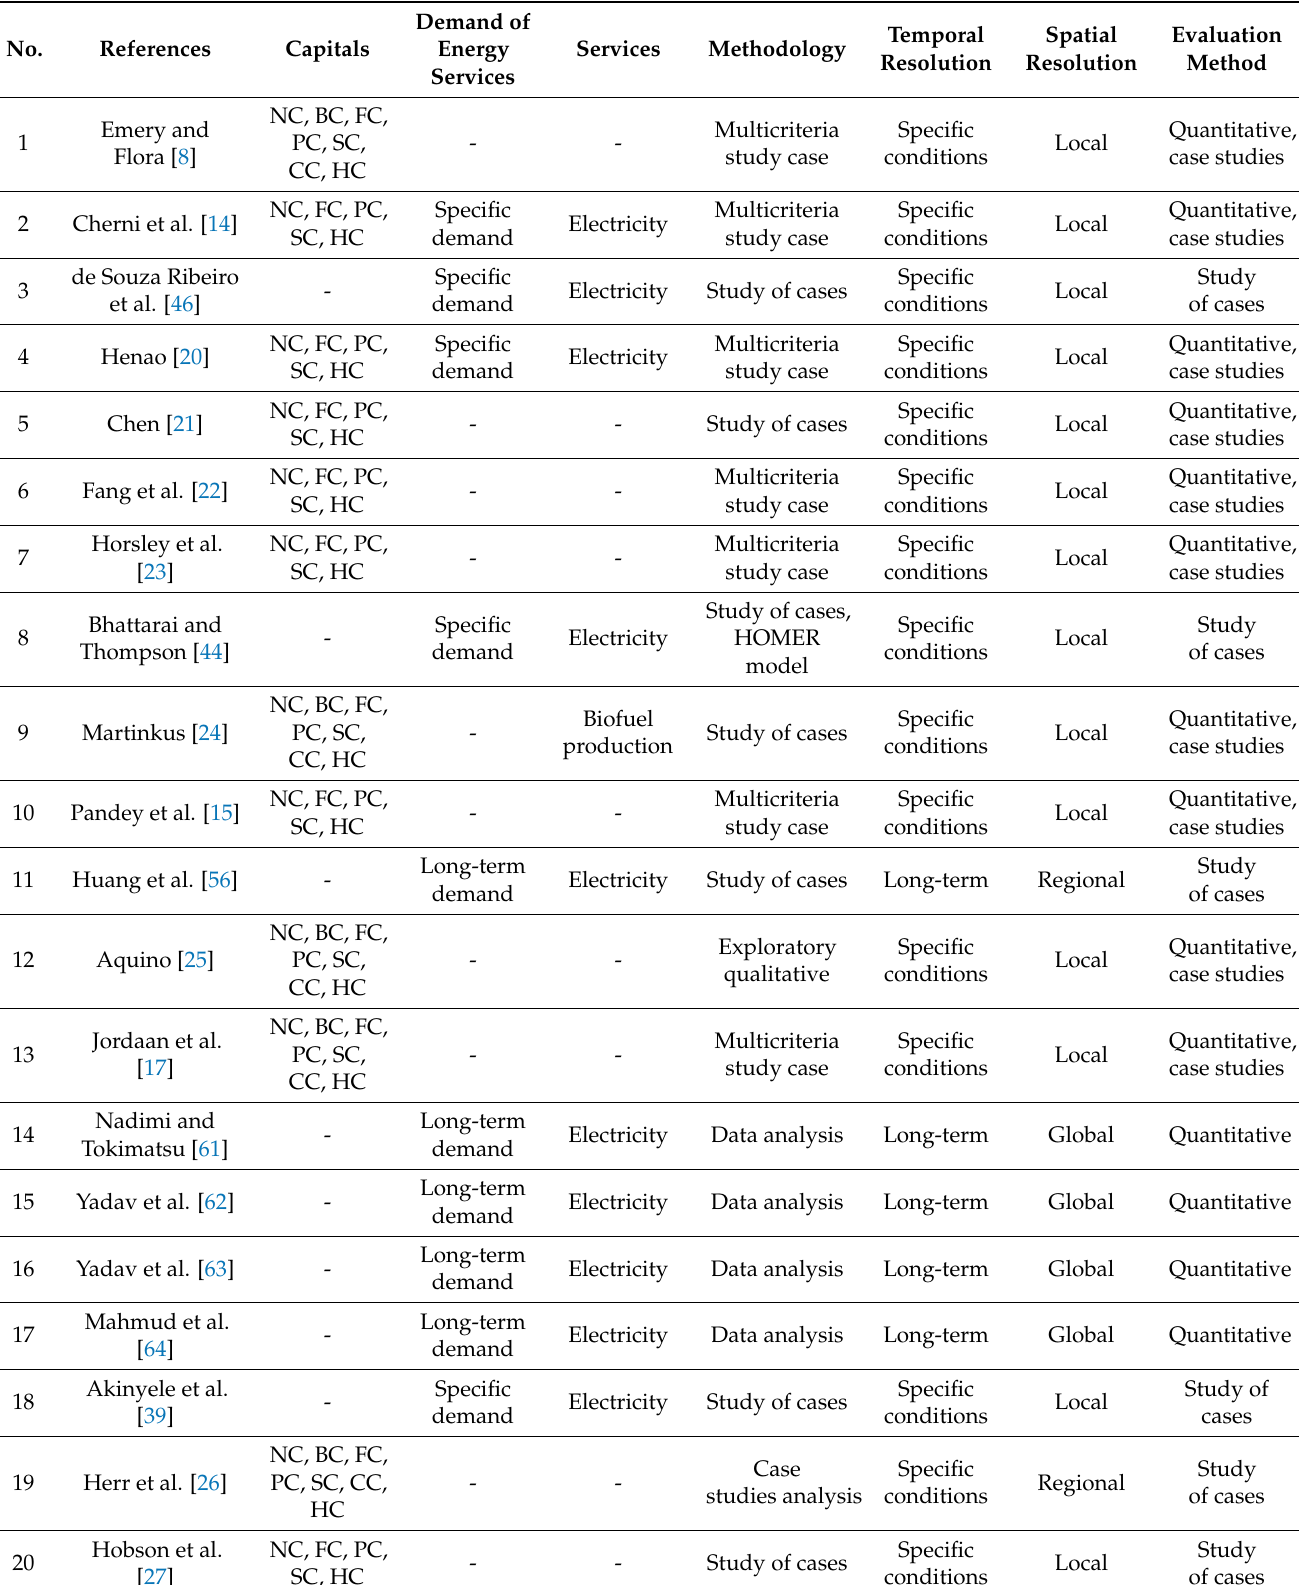
Table 4. Energy planning models factors for remote